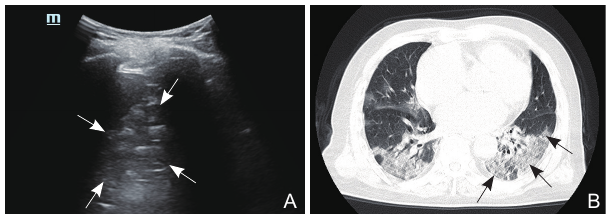
A B Figure 3 Case 3, a 78 years-old male. Ultrasound visualization of lung consolidation in L3 score (A) is basically consistent with CT (B).